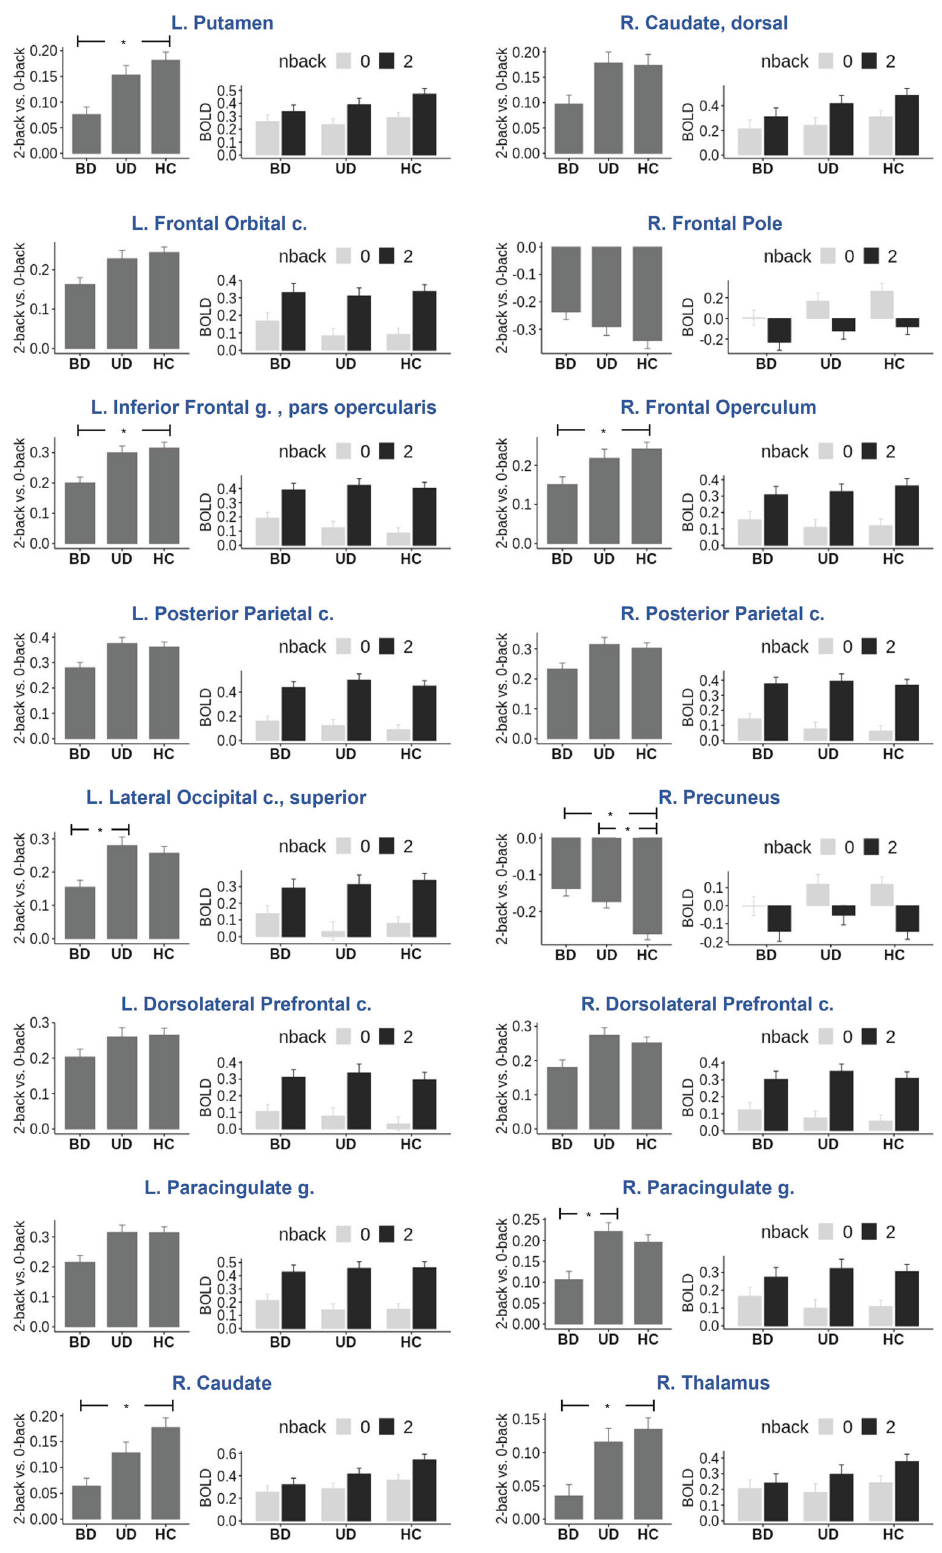
Fig. 3 Percent signal changes in each region of interest (ROI) showing the main effect of group. For each ROI, the plot on the left shows the 2-back vs. 0-back differences in activation, while the plot on the right shows percent signal changes separately for 0-back and